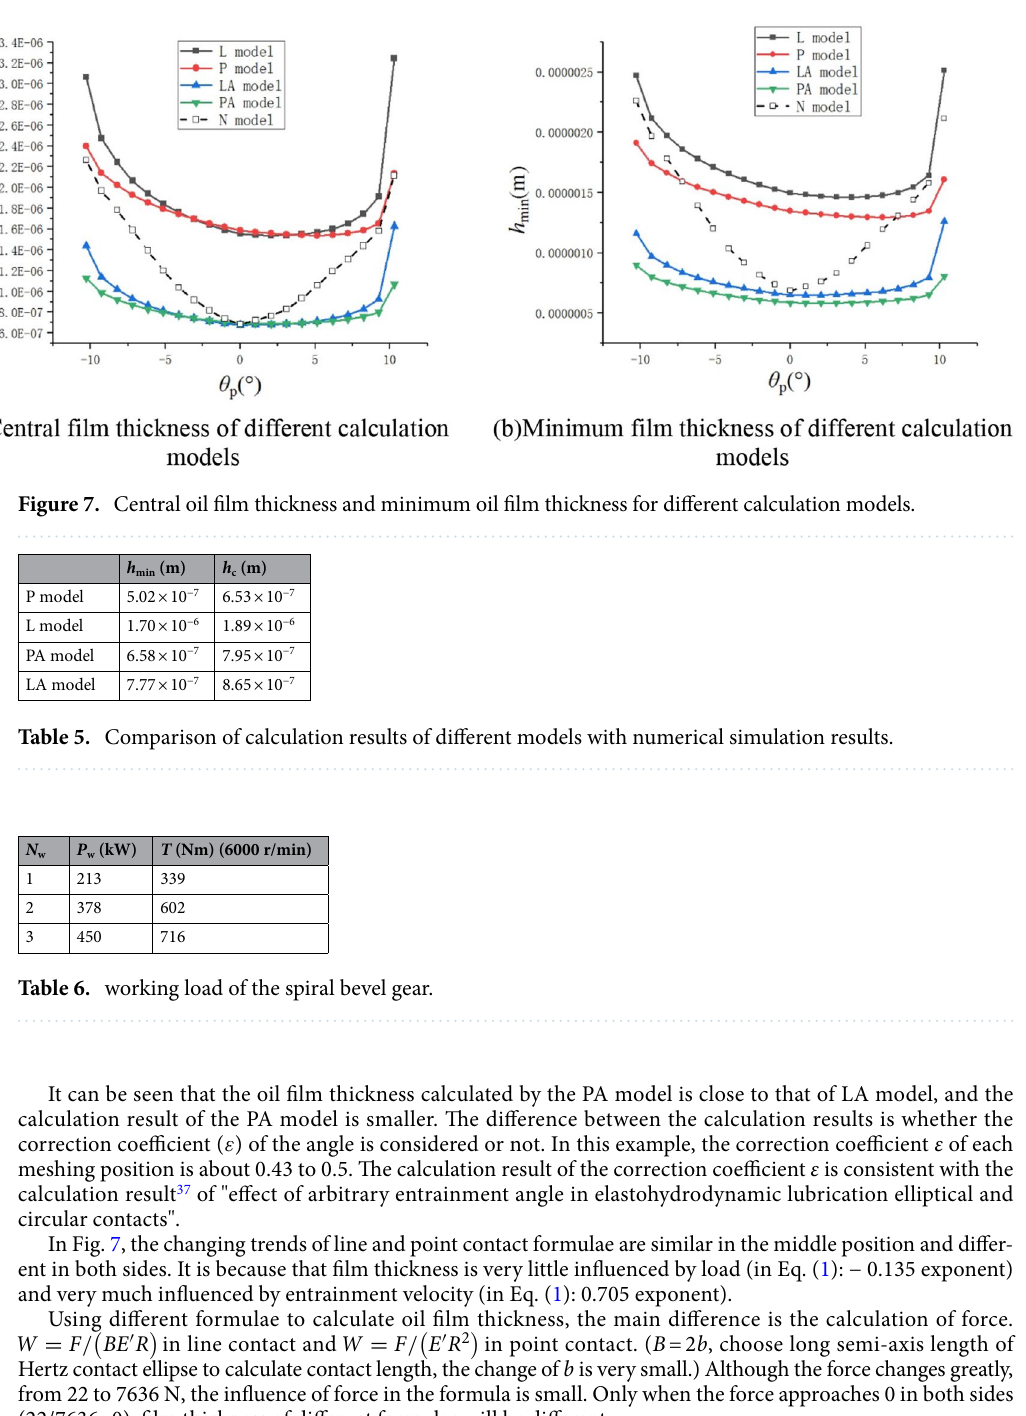
(Table 5): it can be found that the calculation of the minimum film thickness by LA model is more accurate, and the prediction of the change tendency of the film thickness is more accurate. In conclusion, LA model is the closest model to the simulation results of the point contact numerical model (N model). For the lubrication analysis of spiral bevel gears, it is recommended to use the LA model rather than L model. Effect of working load on oil film thickness of spiral bevel gear.